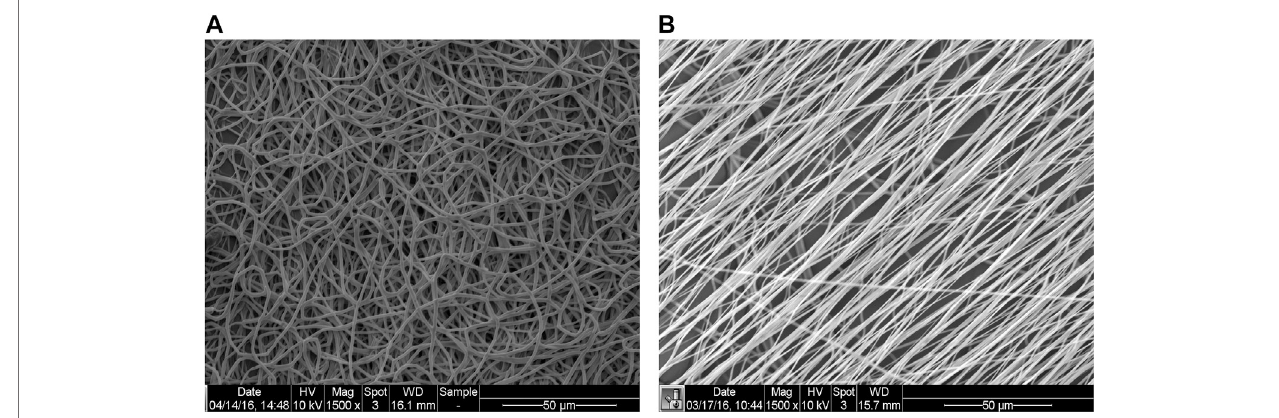
FIGURE 5 | Representative scanning electron microscopy (SEM) images of random (mandrel speed (cid:1) 500 rpm) and aligned (mandrel speed (cid:1) 4000 rpm) PCL fi bers (panels A and B, respectively) [modi fi ed from (Idini et al.,